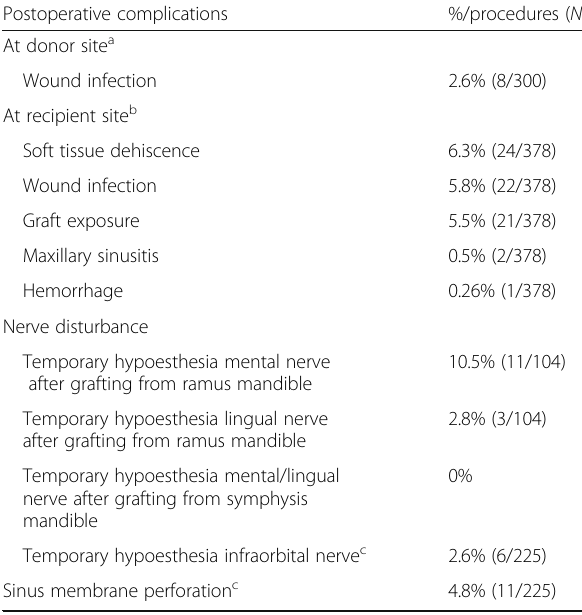
Table 3 Intra- and postoperative complications after autologous bone